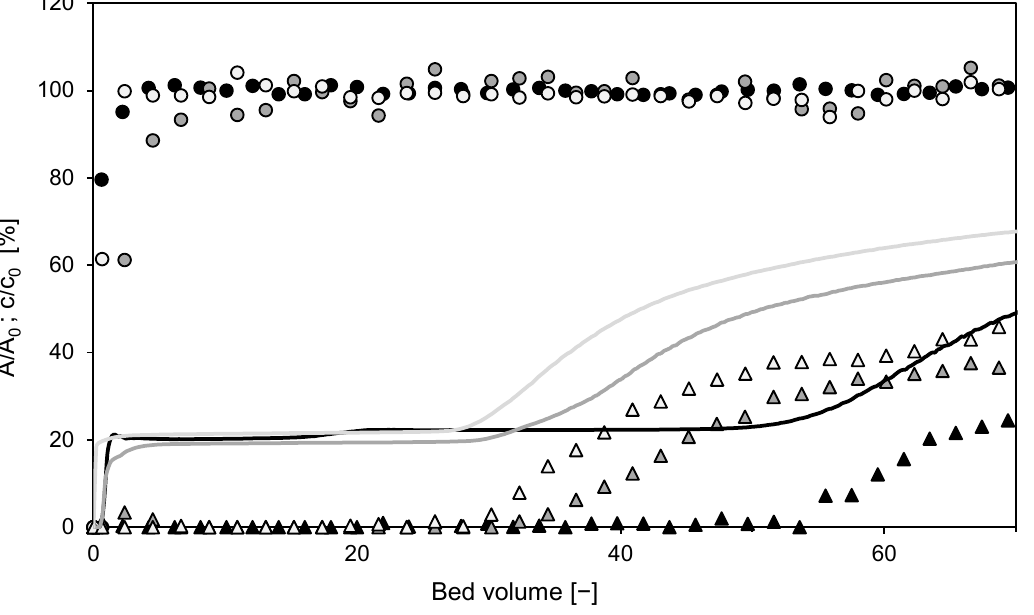
Figure 14. Overlay of chromatograms from repeated cycles using the laboratory membrane module in flow-through mode. The solid line is the relative outlet stream absorbance, which is a superposition of BSA and DNA outlet concentrations. Symbols represent the relative concentration of BSA ( ● ) and DNA ( △ ) in collected fractions. The color of lines and symbols distinguishes individual cycles: black–1st cycle, gray–2nd cycle, and light gray-3rd cycle.